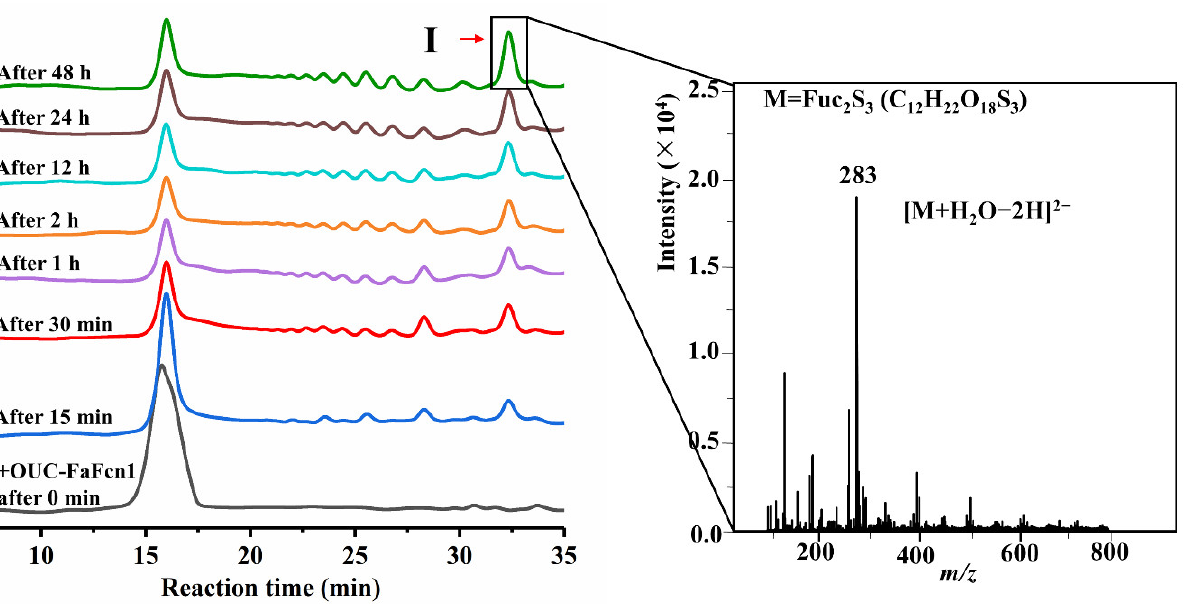
Figure 4. HPLC analysis of degradation products that change over time and the ESI-MS spectrum of the principal product Ⅰ .